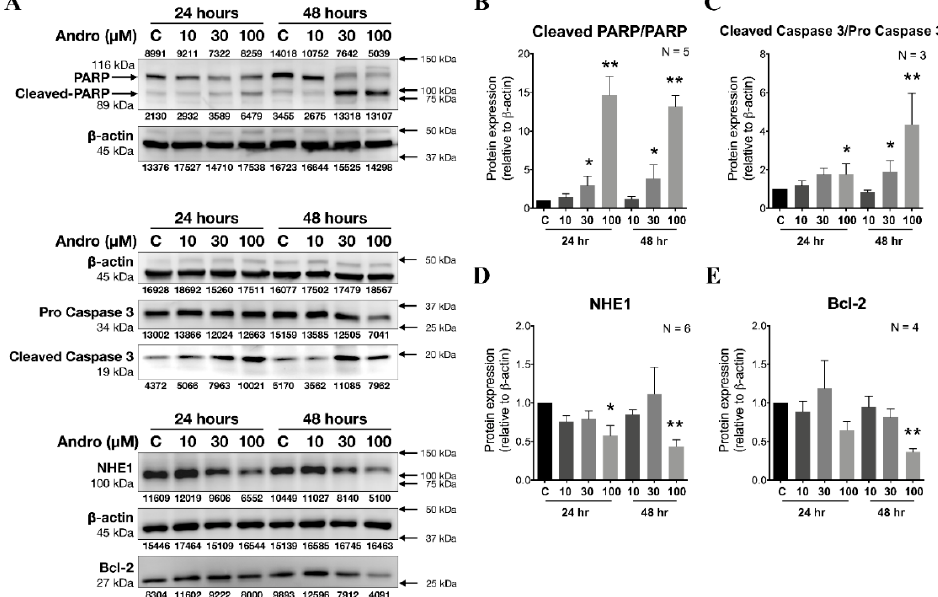
Figure 7. E ff ect of chronic treatment of Andrographolide (Andro; 10–100 µ M) (24 and 48 h) on the expression of Na + / H + exchanger isoform 1 (NHE1) and apoptotic proteins in HeLa cells. ( A ). The Western blot results show the changes of isoforms of poly-ADP-ribose-polymerase (PARP), Cleaved PARP, pro Caspase 3, cleaved Caspase 3, Bcl-2, and β -Actin expression (marked at the farthest left) after 24 and 48 h treatment with Andrographolide (10–100 µ M; marked at the top) in the HeLa cells. Note that the expression of each band is shown right under or above the blot; the predicted size of protein marker is shown at the right of the blot; the size of the detected protein is shown at the left of the blot. ( B – E ) The histograms show the relative expression ratio of Cleaved PARP and PARP, the ratio of cleaved Caspase 3 and Caspase 3, NHE1 and Bcl-2 to β -Actin that were averaged for several experiments similar to those shown in A , respectively. The * p < 0.05 and ** p < 0.005 versus the control, respectively. Error bars represent the mean ± SEM (standard error